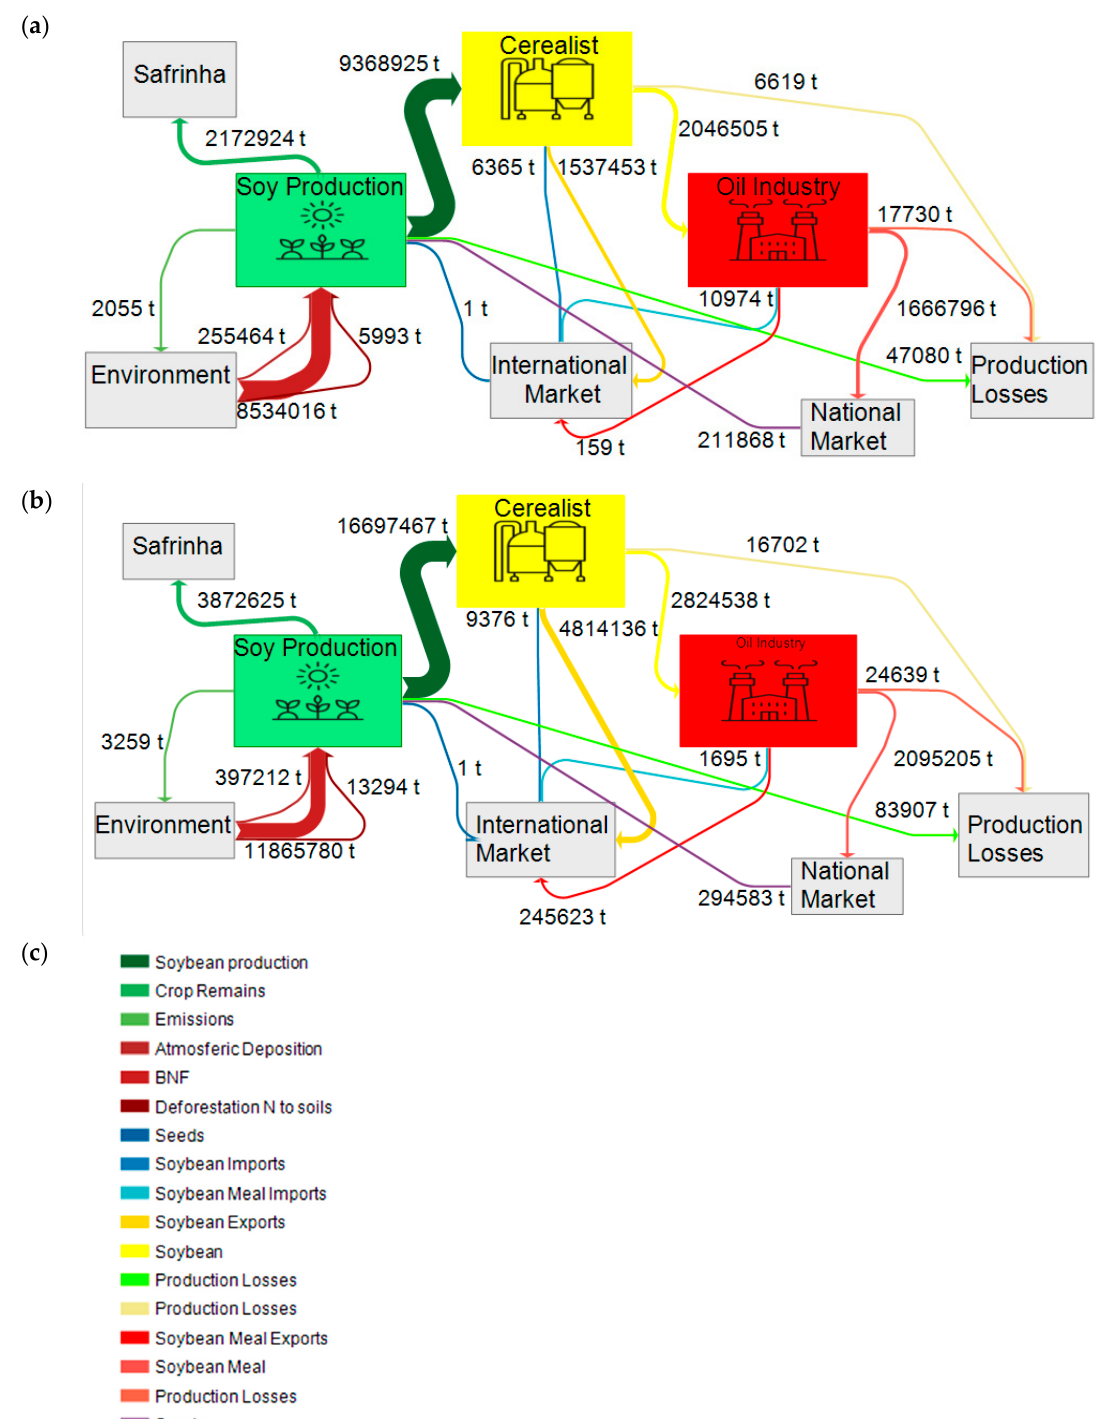
Figure 2. Nitrogen flows in the soybean and soybean meal production system in Brazil in tons per year. ( a ) Flows of nitrogen in 2007. ( b ) Flows of nitrogen in 2019. ( c ) Legend of the arrows, the colors correspond to the direction of the flow, being divided into 3 large compartments: Soy production (green), Sector Cerealist (yellow), Processing industry (red). The gray compartments are important sections that supply or are the destination of some of the nitrogen flows, and they are the production of the second grain harvest (“safrinha”), the environment, the international and national market, and losses during the production cycle.